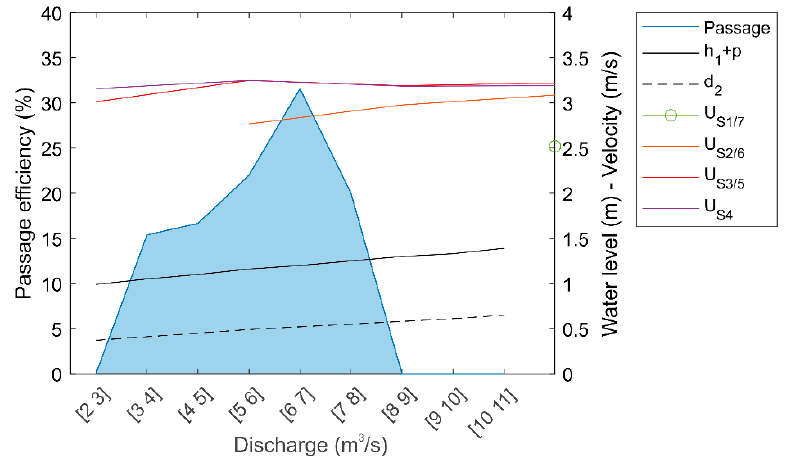
Figure 8. Passage efficiency of the Palencia weir pooled by cubic meter of discharge. Water depth and velocity changes in each section (see Figure 5) according to changes in discharge.